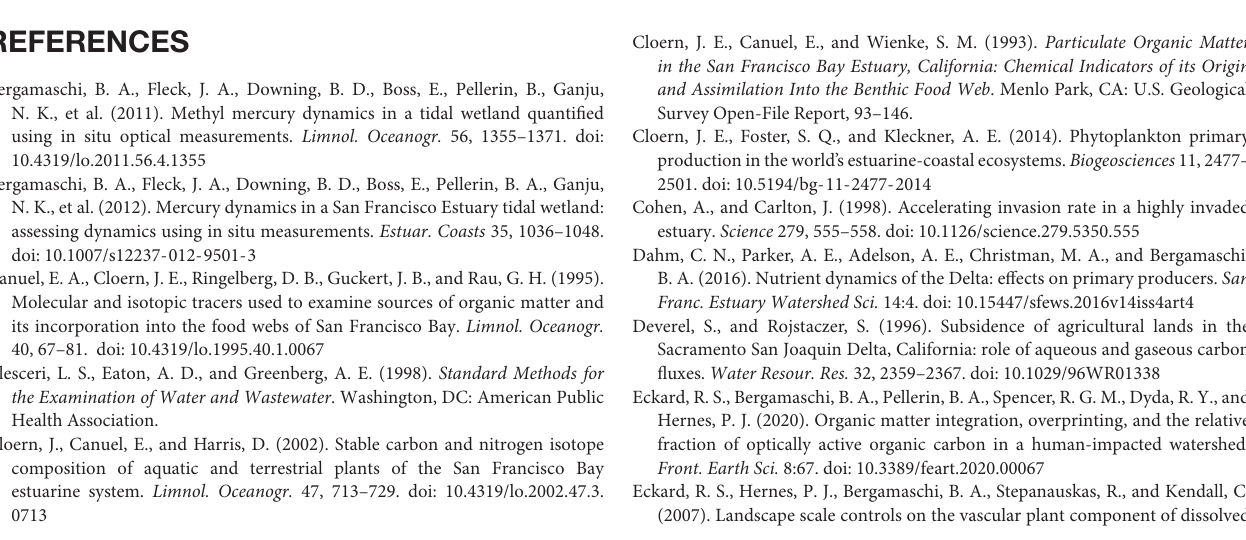
FIGURE S1 | Sacramento River hydrograph across the sampling period with red lines marking the approximate sampling times. FIGURE S2 | A graphic showing the potential shift in POC C:N a with time in the northern SFBE. Data and corresponding citations are given in section “North San Francisco Bay Estuary Particulate Organic Carbon Now and Then”. TABLE S1 | All data for all stations analyzed for lignin. TABLE S2 | Month by month comparisons of significant differences using two-tailed t -test assuming unequal variance. Shaded cells represent p -values <